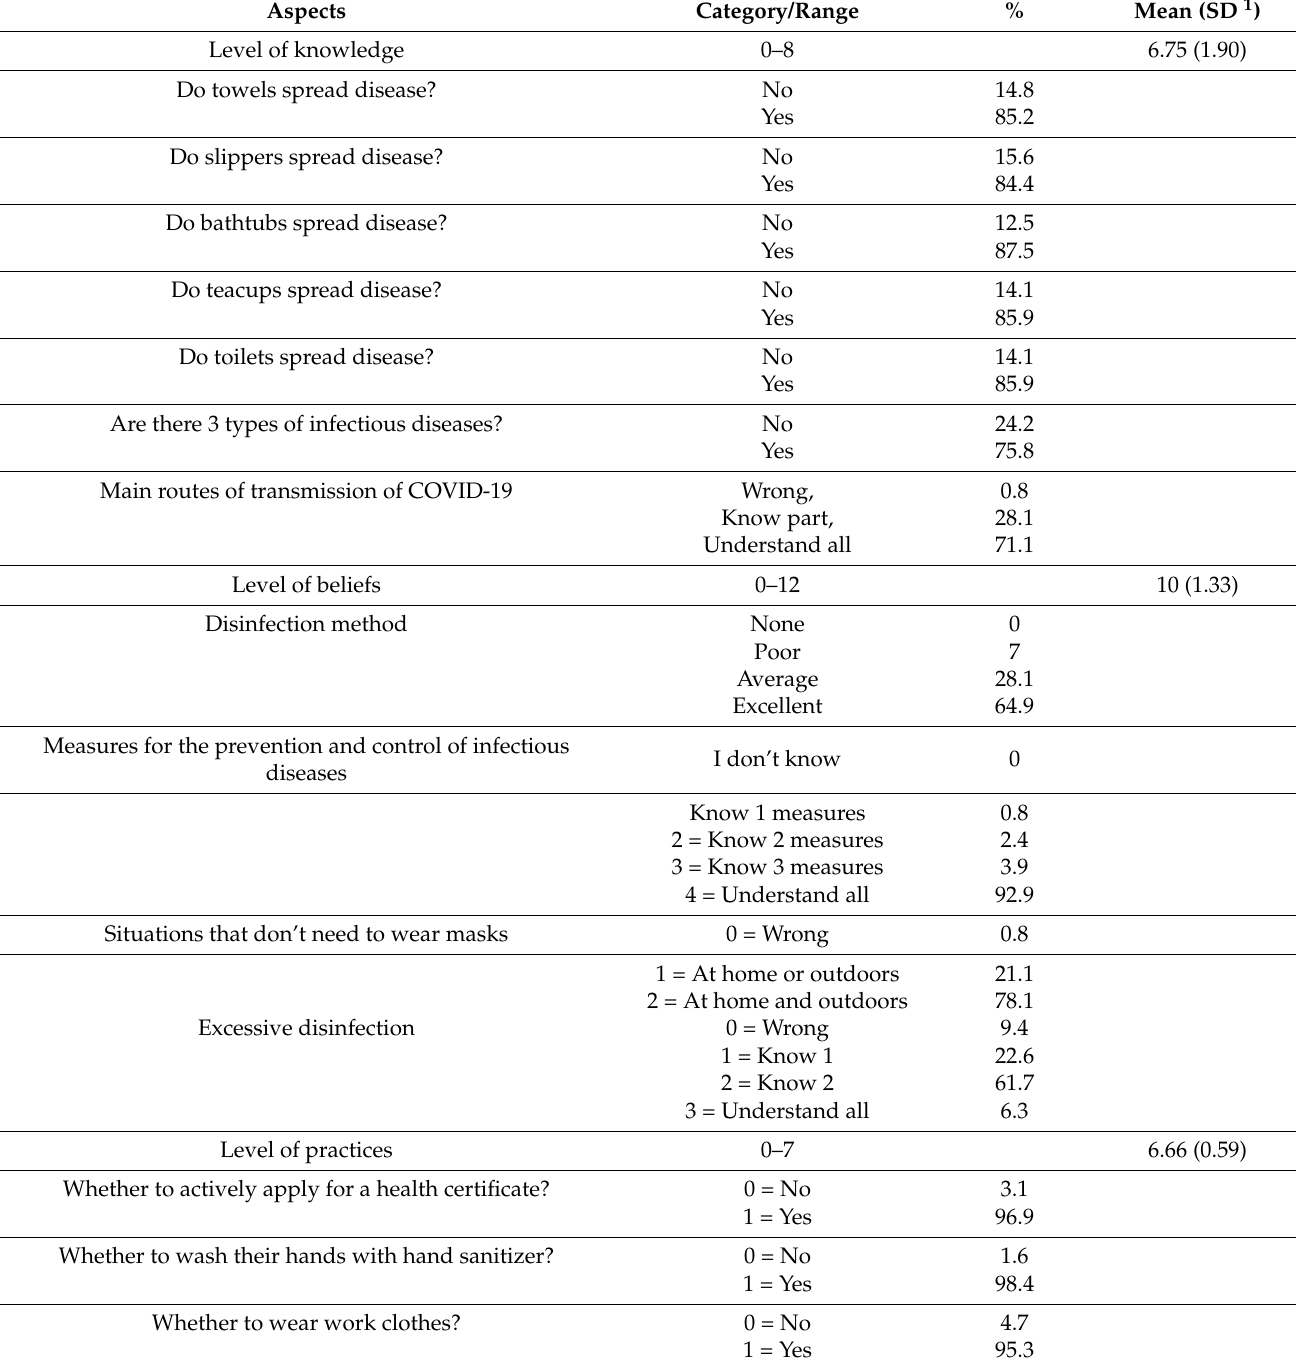
Table 2. Level of knowledge, beliefs, and practices towards the prevention and control of infectious